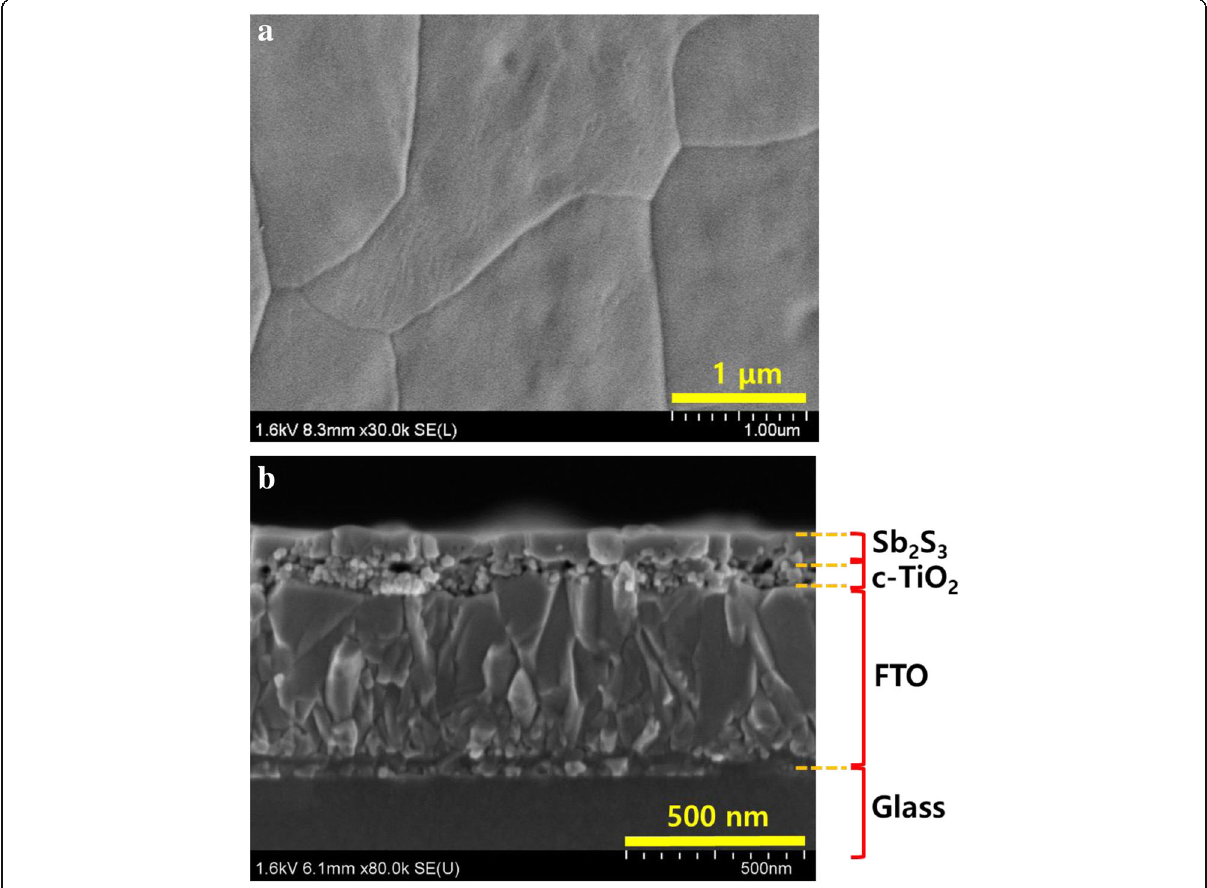
Fig. 2 a Top view and b cross-sectional SEM images of Sb 2 S 3 absorbing layer after annealing at 350 °C for 2